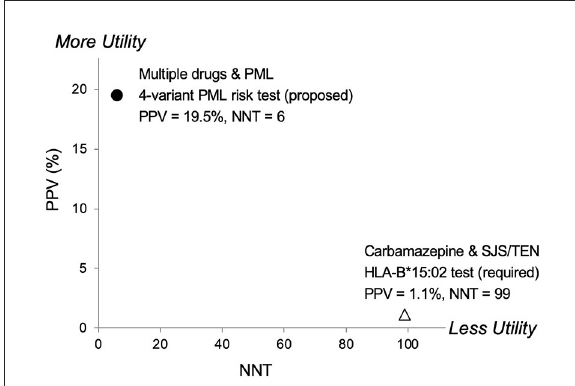
FIGURE3 Predictive risk comparison to HLA-B*1502, positive predictive value (PPV) vs. number needed to treat (NNT). Results for a 4-variant PML risk test are shown in comparison to the HLA-B*15:02 test that is required in Asian populations before administering carbamazepine (CBZ). CBZ is a cause of the serious adverse event Stevens-Johnson Syndrome (SJS) and Toxic Epidermal Necrolysis (TEN). The proposed 4-variant PML risk test data point ( (cid:8) ) is based on the total drug-exposed PML cases (Table 5) and a PML incidence rate of 3% (17). The HLA-B*15:02 SJS/TEN risk test data point ( 1 ) is based on results reported in Shi et al. (54). More Utility is defined as higher PPV and lower NNT and Less Utility is defined as lower PPV and higher